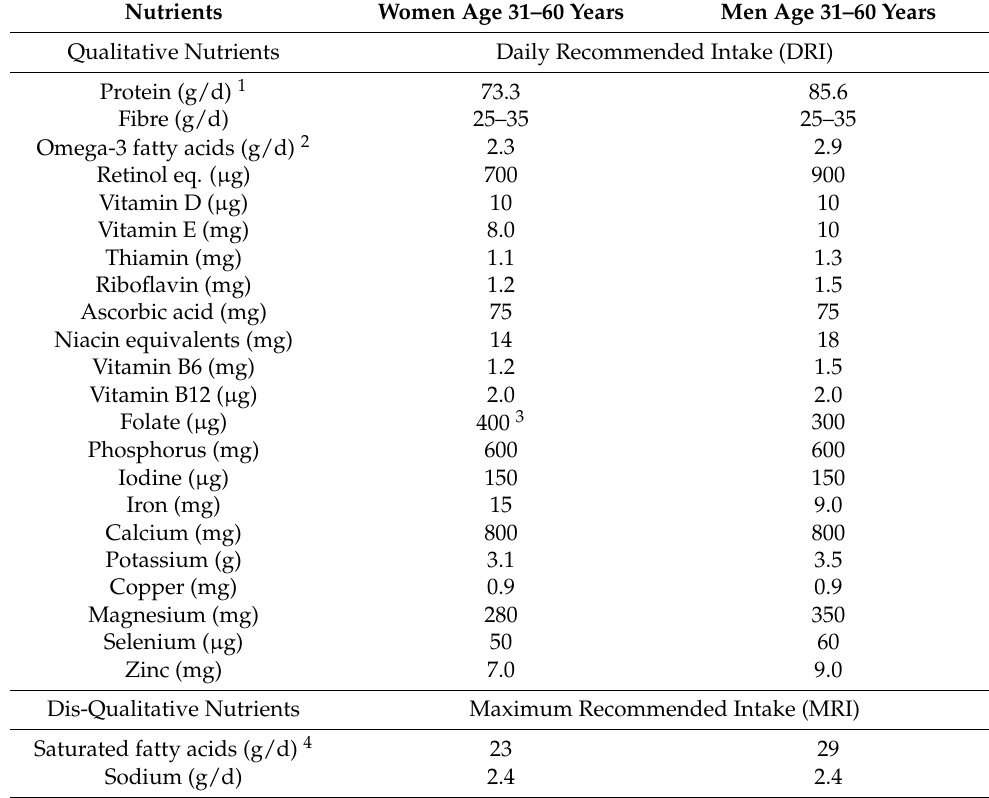
Table A1. Daily recommended intake and maximum recommended intake of macro- and micronutri- ents for men and women between 31–60 years. the table is adapted from calculations done by [21].